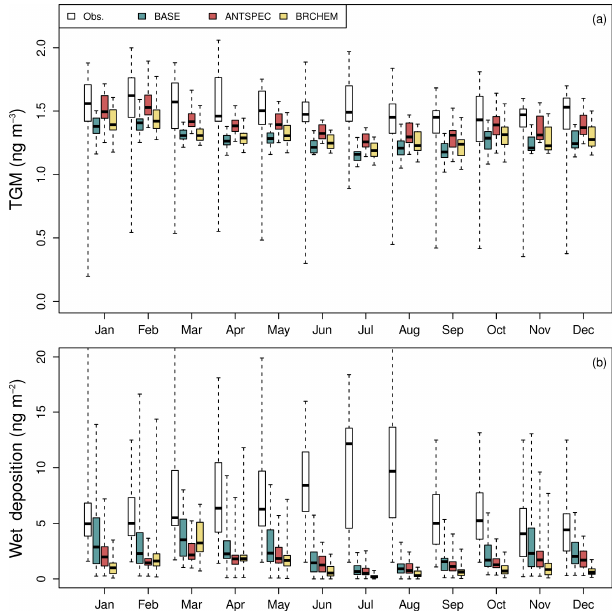
Figure 7. Monthly distribution of observed and modelled values for BASE, ANTSPEC and BRCHEM1 experiments at measurement stations. (a) TGM concentrations; (b) wet deposition